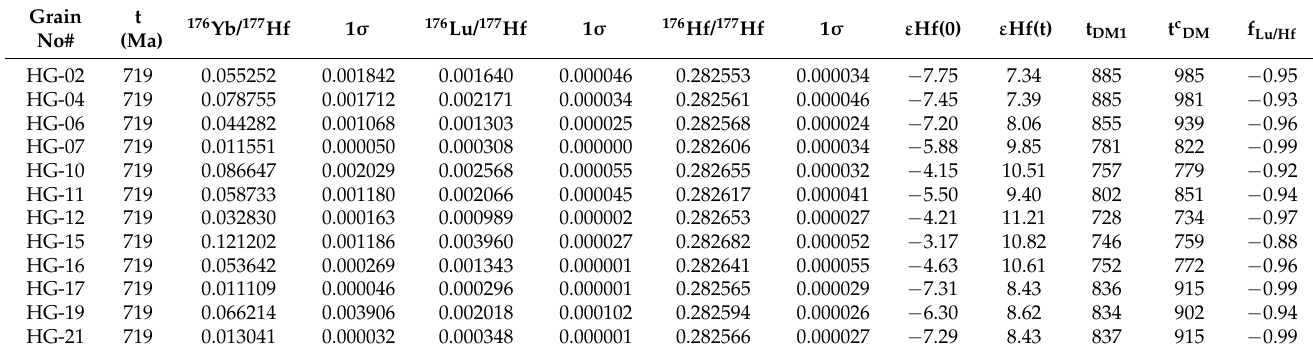
Table 3. Single zircon Lu–Hf isotopic data for Haweit granodiorites from NE Sudan.